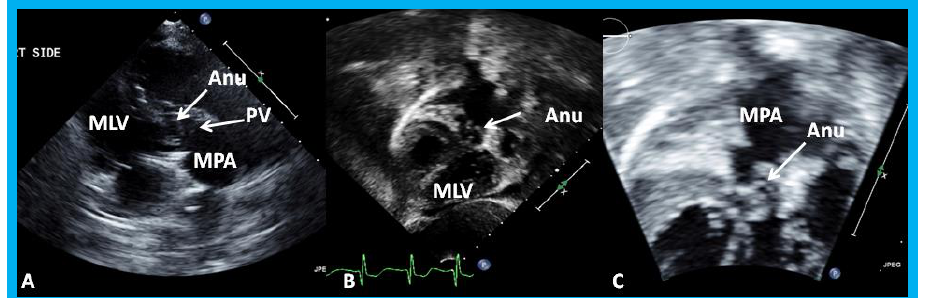
Figure 19. Selected video frames from a right parasternal ( A ) and subcostal four chamber ( B ) views of the morphologic left ventricle (MLV) demonstrating aneurysm (Anu) projecting into the MLV outflow tract, producing obstruction: The Anu is located just below the pulmonary valve (PV). The main pulmonary artery (MPA) is dilated. ( C ) An enlarged view of B illustrating the aneurysm and MPA dilatation. Reproduced from Yarrabolu T.R., et al. [23].